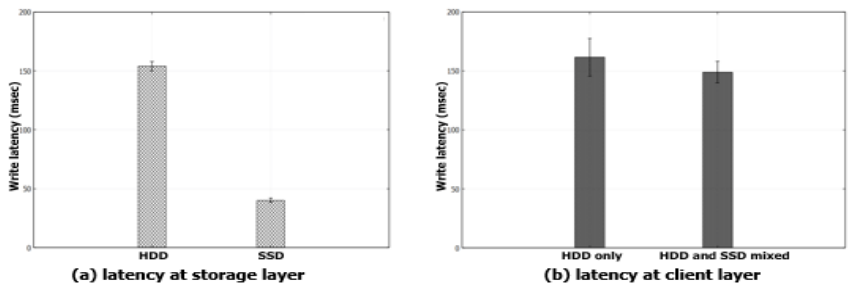
Figure 4. Observation 2: clients do not obtain the benefit of SSDs (Solid State Drives) under the heterogeneity-oblivious